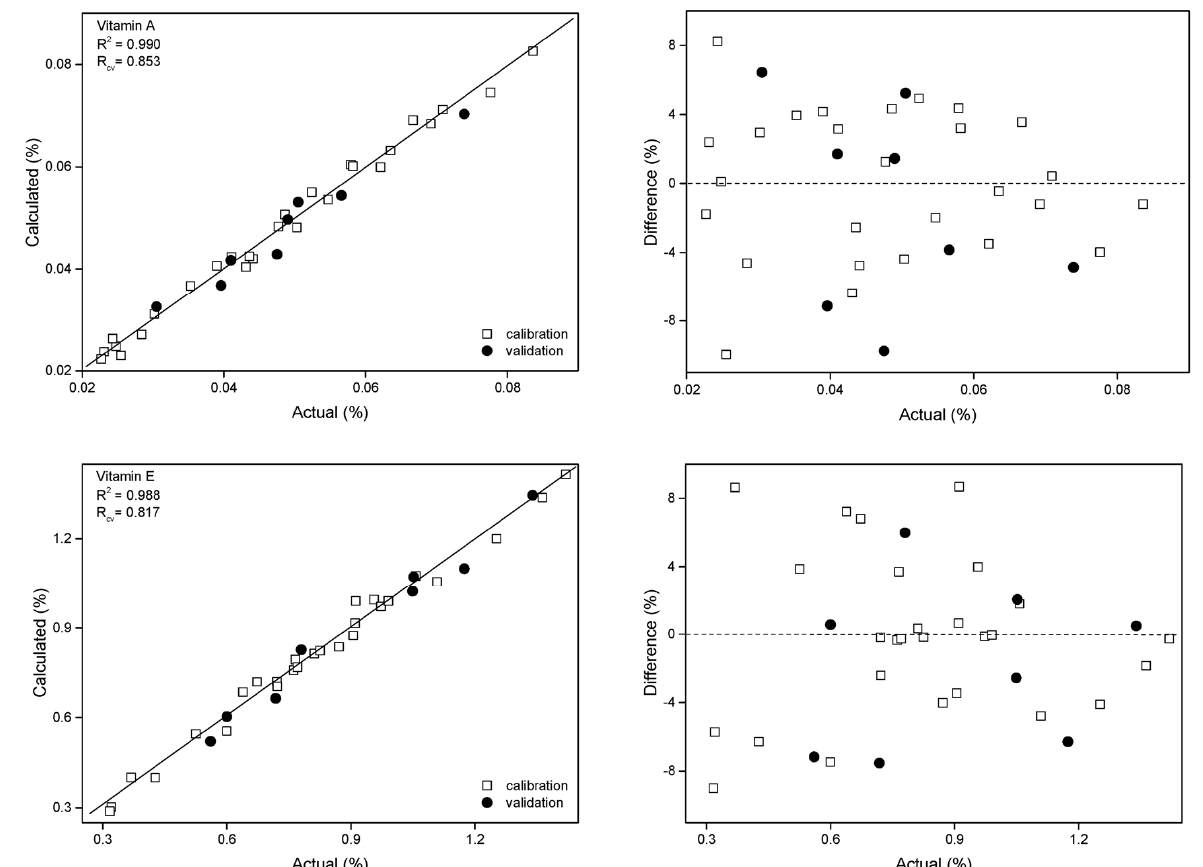
Figure 4. Prediction plots (left panel) and relative errors (right panel) for vitamins A (top) and E (bottom) content in eucerin-based ointment obtained using PLS models based on Raman